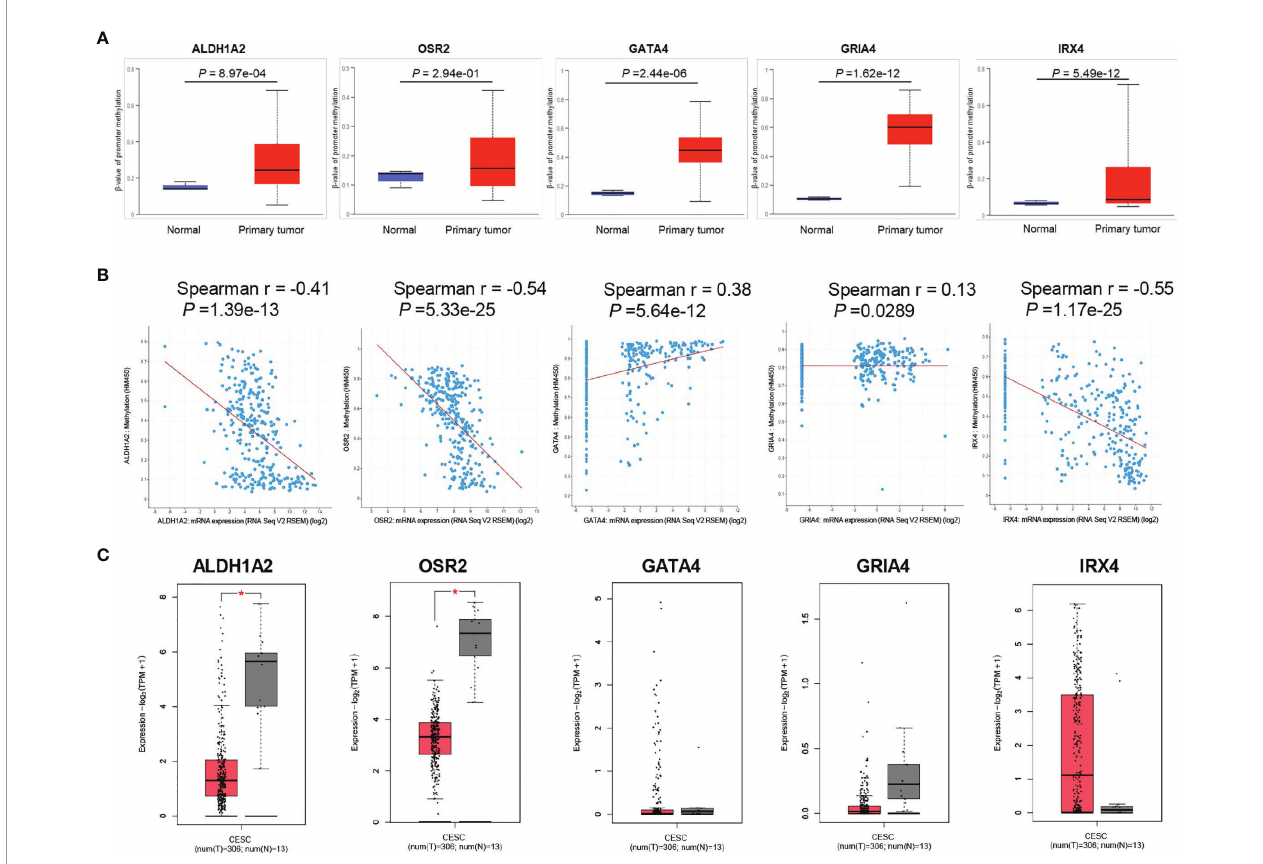
FIGURE 2 | Promoter methylation analysis of HPV-related gene signature in TCGA-CESC cohort. (A) Box and whisker plots revealed methylation b -values of HPV- related gene signature between tumor and normal tissues, P values were presented for each gene. (B) Spearman correlation analysis between gene promoter methylation and relative transcript levels for each gene were performed by the cBioPortal tool, P values were presented for each gene. (C) The signi fi cantly different expression level of each gene was presented by boxplots, * P <